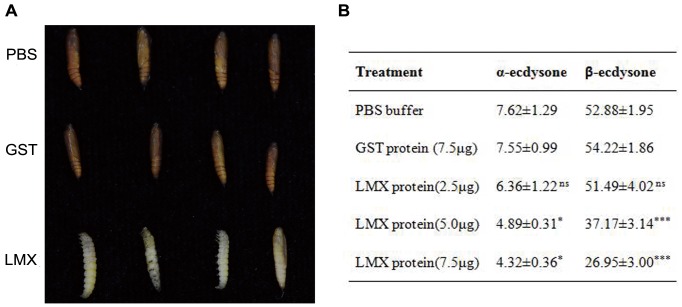
Molting of rice leaf folder larvae fed with LMX protein.
A. Larvae fed with LMX-GST fusion protein delay molting. B. Ecdysone content in the larvae of rice leaf folder feeding on LMX fusion protein on the 3rd day post-infestation (ng/mg). The larvae fed on 2.5∼7.5 µg LMX protein-applied rice leaves were treatment groups, while the larvae fed on PBS buffer-applied rice leaves and 7.5 µg GST tag protein-applied rice leaves were control groups. Pictures were taken and ecdysone was measured after 72 h feeding. Values are presented as means ± SD of triplicates. * denotes p<0.05; *** denotes p<0.001. ns denotes no significant difference.